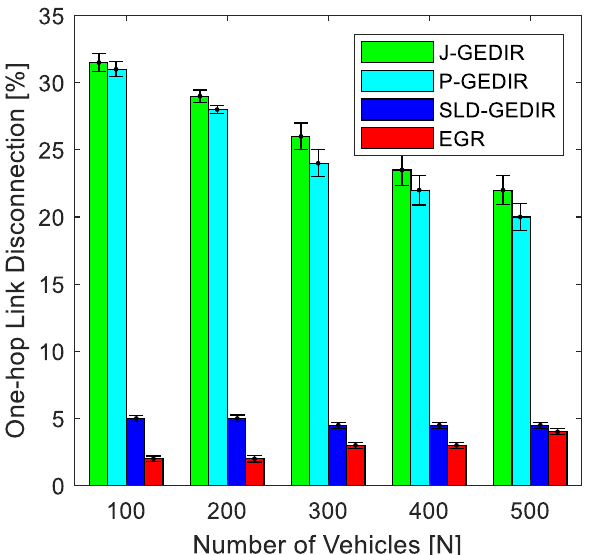
Figure 16. Effect of vehicle density on one-hop link disconnection.